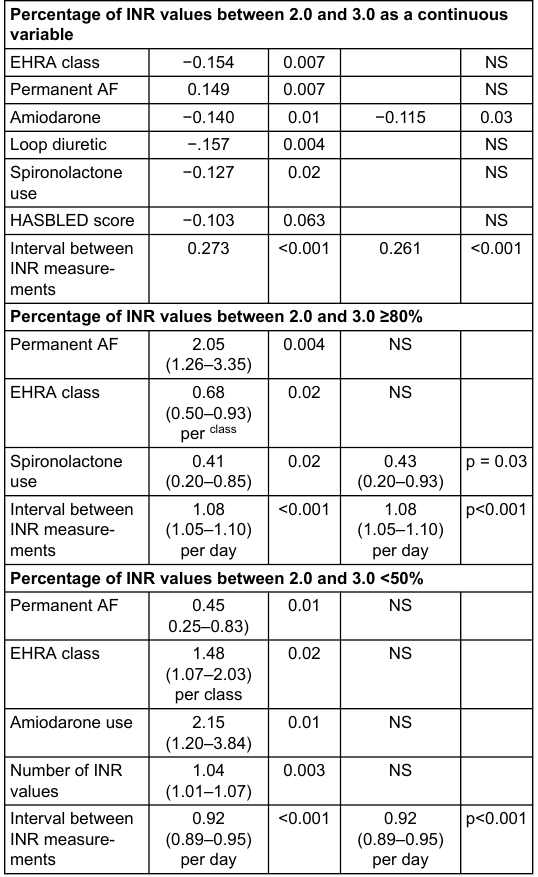
Table 2: Predictors of high/low percentage of INR values between 2.0 and 3.0. Univariate p-value Multivariate p-value Percentage of INR values between 2.0 and 3.0 as a continuous